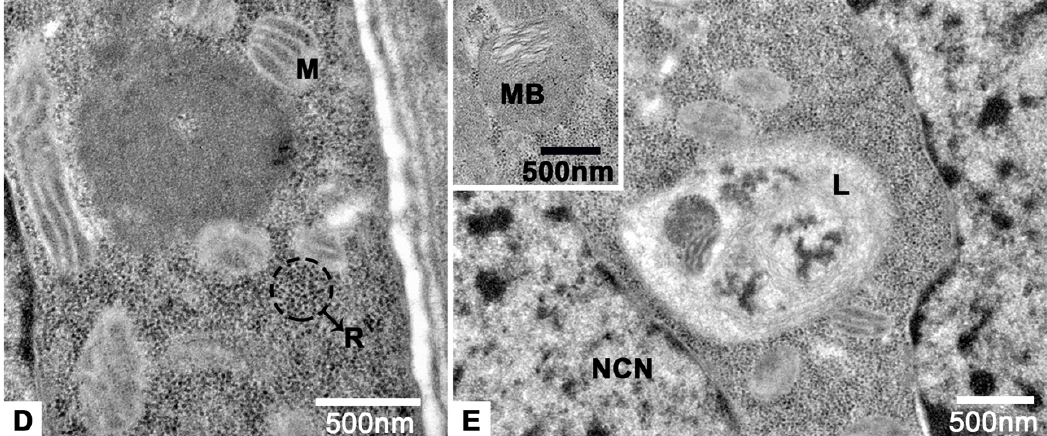
Figure 5. The anterior region of tropharium of T. klimeschi on sixteenth day post-eclosion. ( A ) Logitudinal section of the anterior region of tropharium shows several nurse cells clusters. In the dotted white circle, cell projections of nurse cell cluster extend in all directions are obvious. In the dotted black circle, an interstitial cell located next to the basal lamina is observed. ( B ) The peritoneal sheath and basal lamina. ( C ) The cytoplasmic contents of interstitial cell. ( D , E ) The cytoplasmic contents of nurse cell cluster. In the dotted black circle, the granular ribosomes are observed. Nurse cell (NC); nucleus of a nurse cell (NCN); interstitial cell (IC); peritoneal sheath (PS); basal lamina (BL); myofibrils (MF); lysosomes (L); nucleoli (NL); mitochondrium (M); nucleus of an interstitial cell (ICN); ribosomes (R); and multilamellar body (MB).